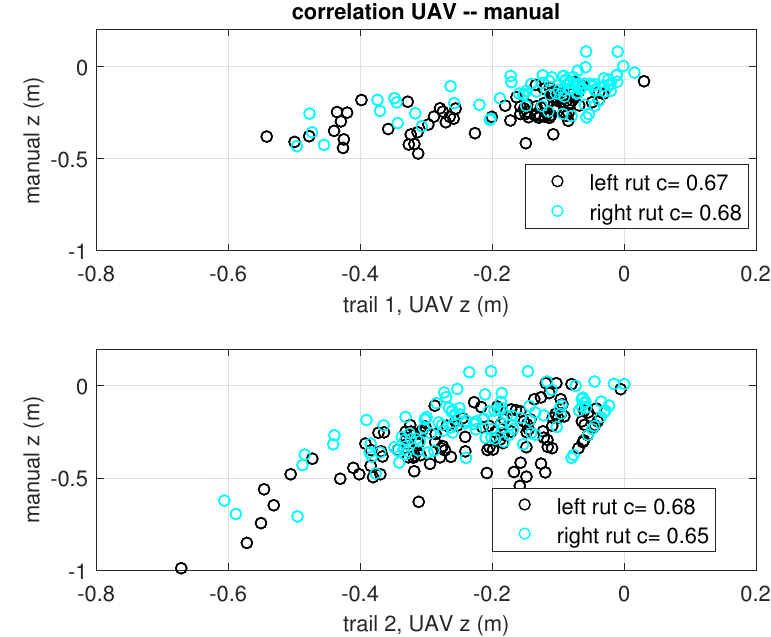
Figure 10. Correlation of the left and right rut depths measured manually and by the UAV method. Trail 1 at the top and Trail 2 at the bottom. The UAV values are extracted from the ground TIN model at the manual measurement points by the standard barycentric